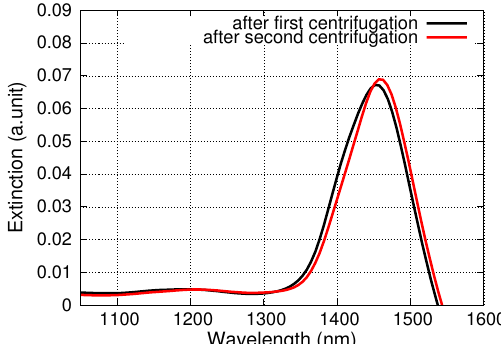
Figure 3. Optical absorption spectra of support-free PGNs prepared by using the one-step detachment method starting from particles supported on CaF 2 . Spectra were recorded after the first and second centrifugation steps. The two spectra